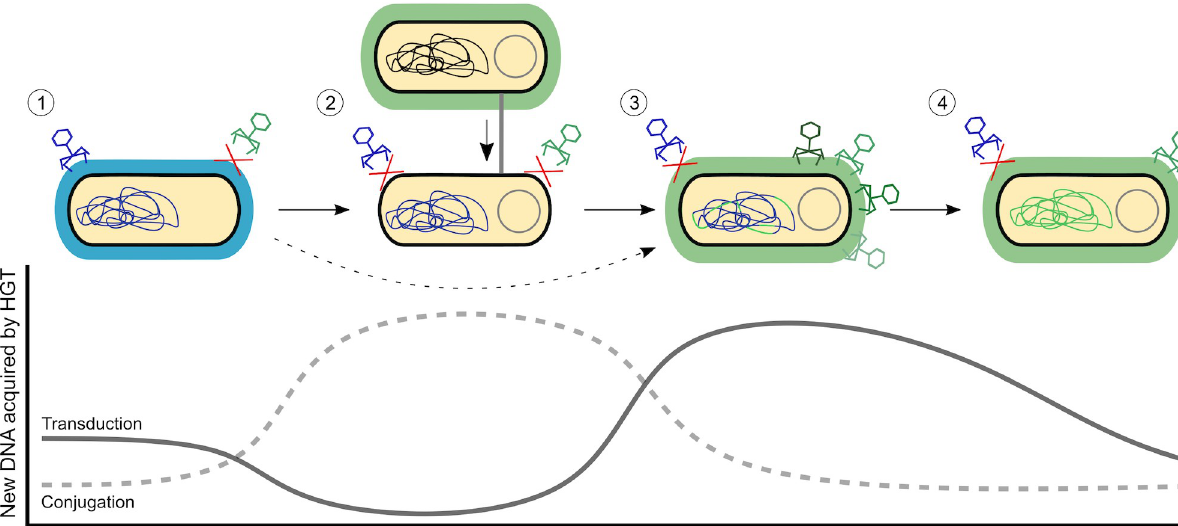
Fig 1. Capsule trading boosts the acquisition of new mobile DNA. The bacterial capsule impacts the horizontal acquisition of novel genetic elements in K . pneumoniae . (1) Phages are able to transfer DNA between bacteria belonging to the same capsular type (capsule is indicated by blue shading surrounding the bacterium). Capsule inactivation (1 ! 2) leads to resistance to phage infection but increases permissiveness to plasmid reception through conjugation. Conjugative plasmids can promote capsule reacquisition (2 ! 3) or direct swap (1 ! 3; dashed arrow), which can lead to a new capsular type (new capsule is indicated by green shading surrounding the bacterium). Then, new capsule type-specific phages will transfer DNA to the bacterium. The amount of novel DNA transduced by the phages will decay over time (1 and 4), since most DNA exchanges would occur among genetically similar organisms. The lower part of the figure represents a conceptual representation of bacterial access to new horizontally acquired genes through the complete process. Plasmids represent an important source of new genes, while phage-mediated access to novel DNA will be particularly important after changing capsular types, when the bacterium have access to novel phages that bring more diverse DNA (from more phylogenetically distant bacteria). HGT AU : AnabbreviationlisthasbeencreatedforthoseusedinFig 1 : Pleaseverifythattheentriesarecorrect : , horizontal gene transfer.